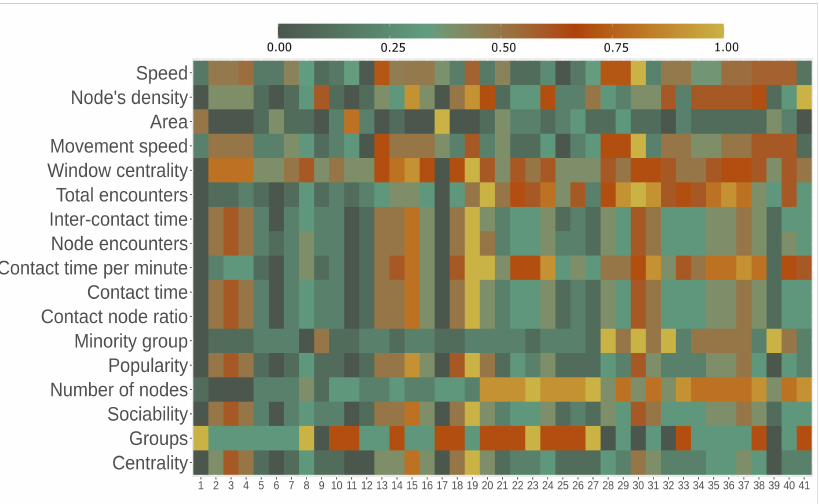
Figure 6. Diversity representation of the forty-one scenario collection, which constitutes the first corpus for the performance evaluation of OppNet routing algorithms. The X -axis is the scenario’s number, and the Y -axis represents the